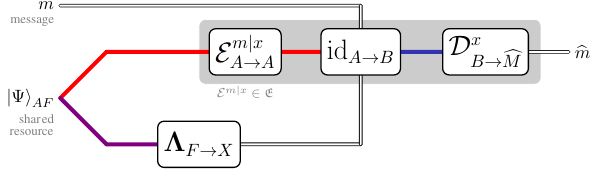
FIG. 5. An enhanced dense coding protocol for the shared resourceful quantum state (cid:2) AF under one-way LOCC decoders. In this protocol, Alice possesses system A (red line), Bob pos- sesses system B (blue line), and Fred possesses system F (purple